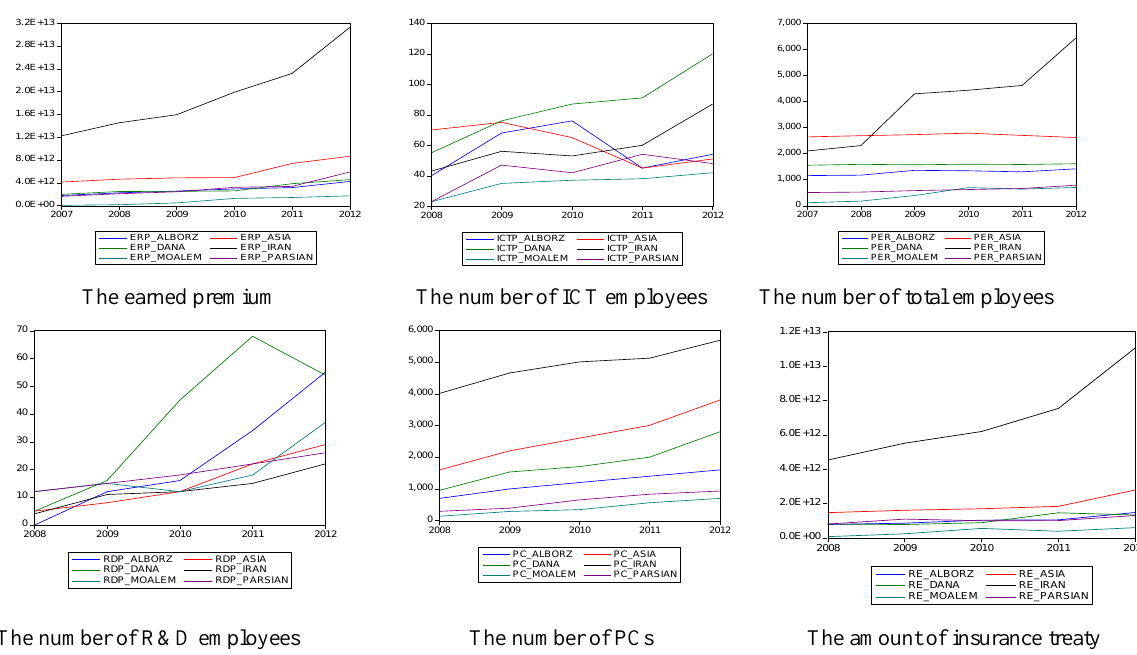
Fig. 1. The trend of some basic statistics for six Iranian selected insurance